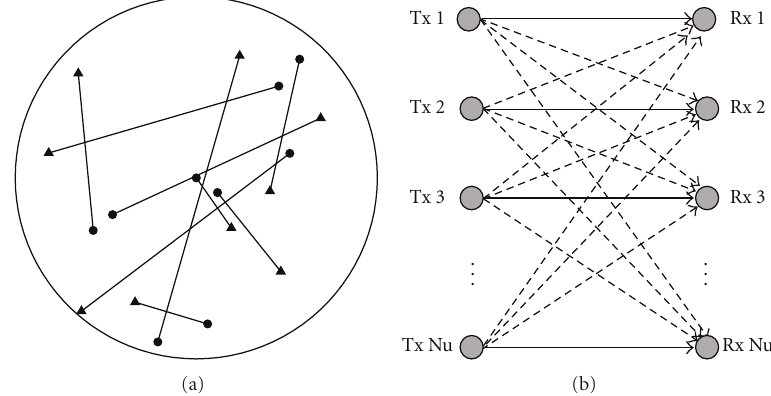
Figure 1: (a) Randomly distributed nodes in ad hoc networks, where the solid triangles denote transmitters and the solid circles denote receivers. (b) Interference channel